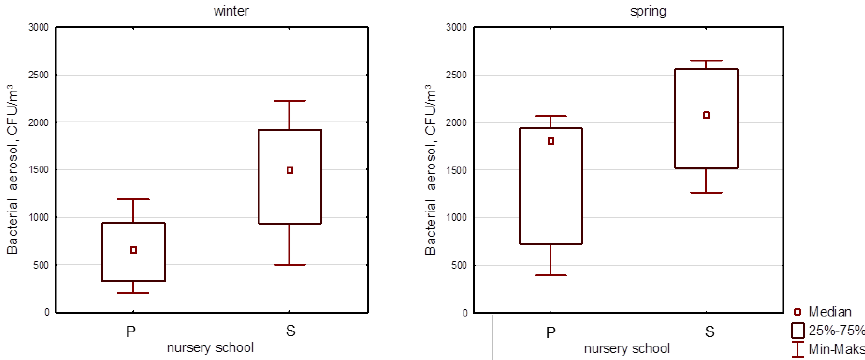
Figure 2. Comparison of bacterial aerosol levels between rural sites (P) and (S) during winter and spring seasons.